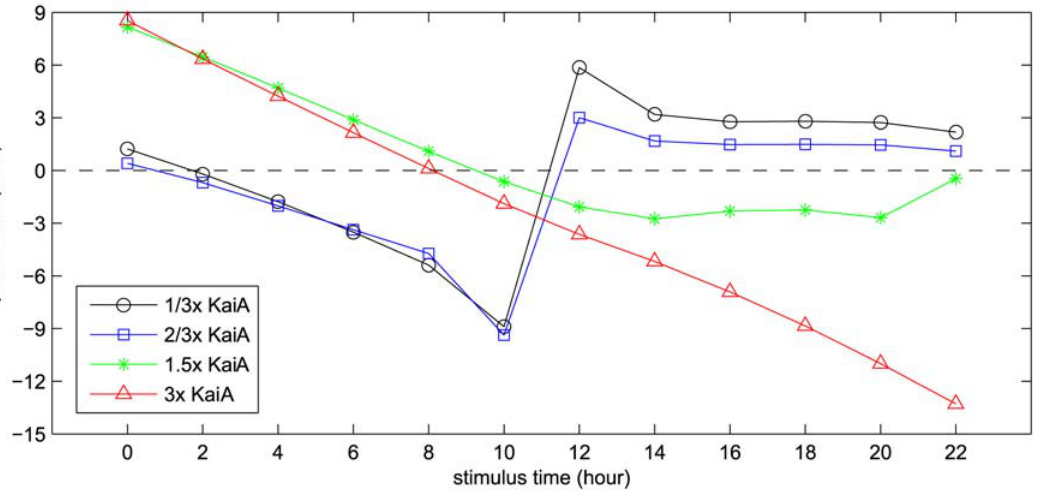
Figure 9. Phase response curves obtained by transient variations in KaiA concentration. Nonstandard KaiA concentrations are used as the 4-hour stimulus pulses, i.e. 1/3 6 , 2/3 6 , 1.5 6 and 3 6 standard amount of KaiA. Parameter set used is the new one obtained in section 2.6 in Text S1.